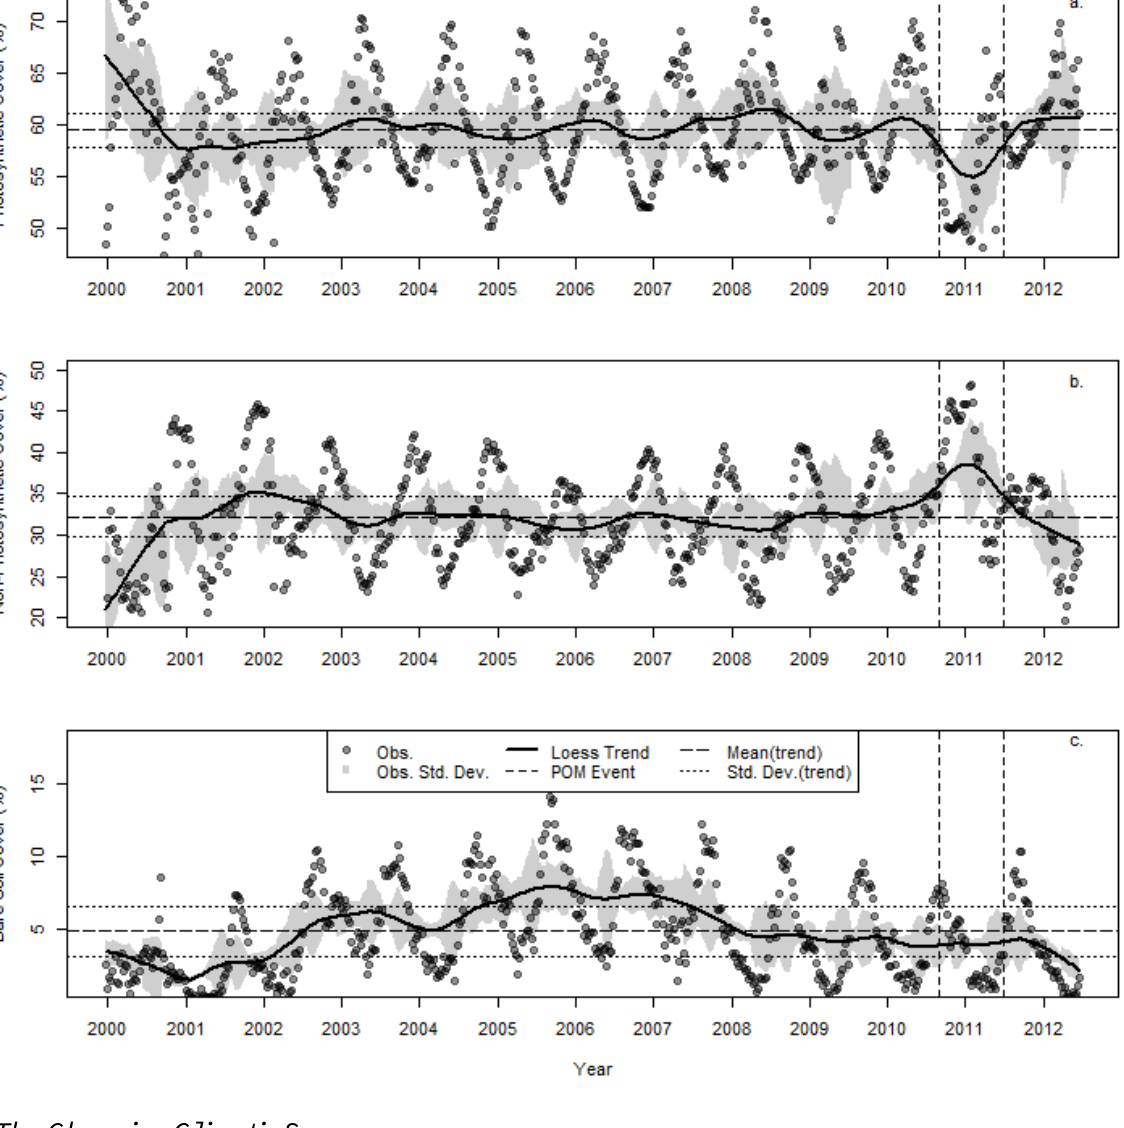
Figure 5. 0.5 km POM average STL trend plots showing the 2000–2012 period with the summer of 2010–2011 marked for each component of MODFC after Guerschman [33]. Subplot ( a ) is the fraction (%) of photosynthetic cover (f